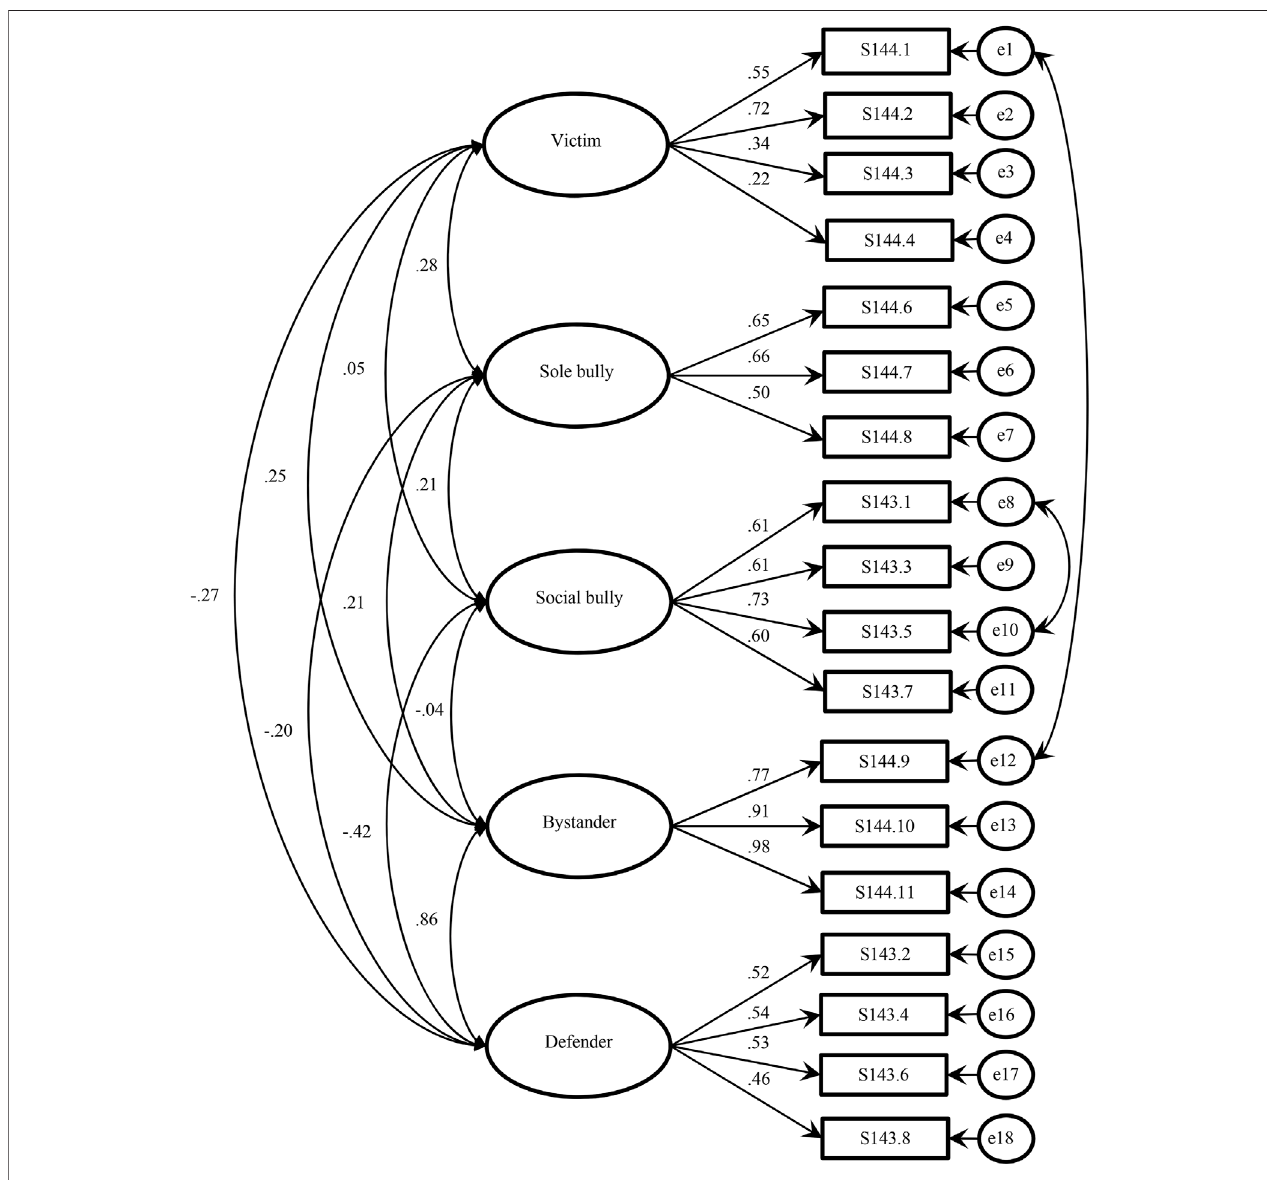
FIGURE 2 | Five-factor model of ERECVE (revised model).